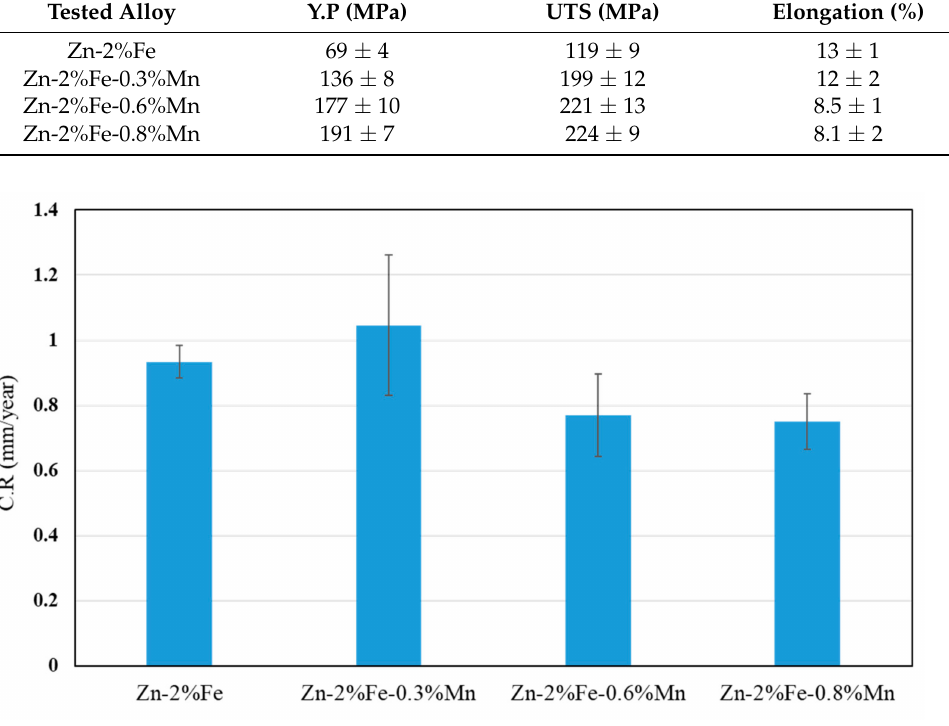
Figure 7. Corrosion rate measurements of Zn-2%Fe with up to 0.8% Mn after immersion test in PBS solution for 14